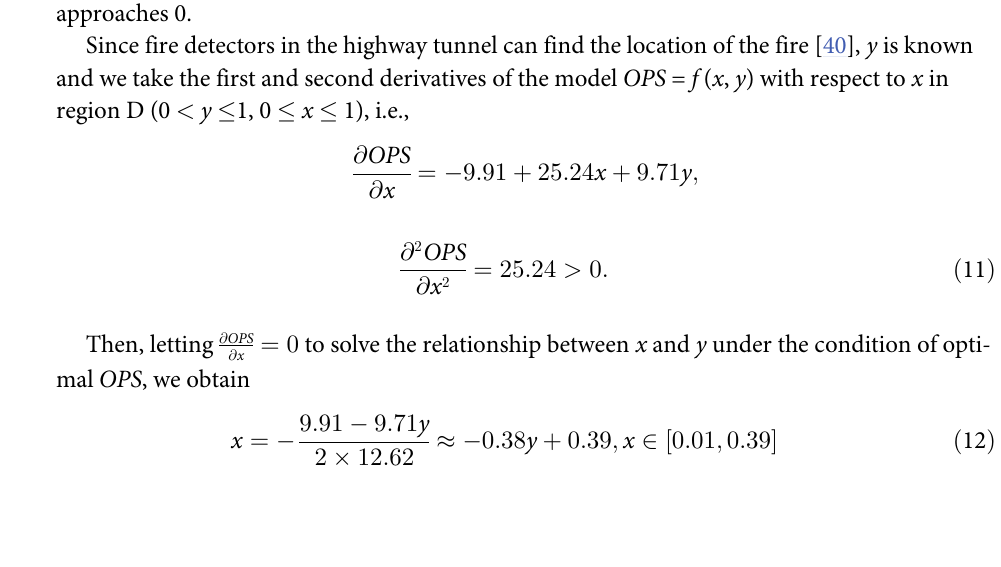
passageway may choose to escape through the pedestrian passageway. This phenomenon could